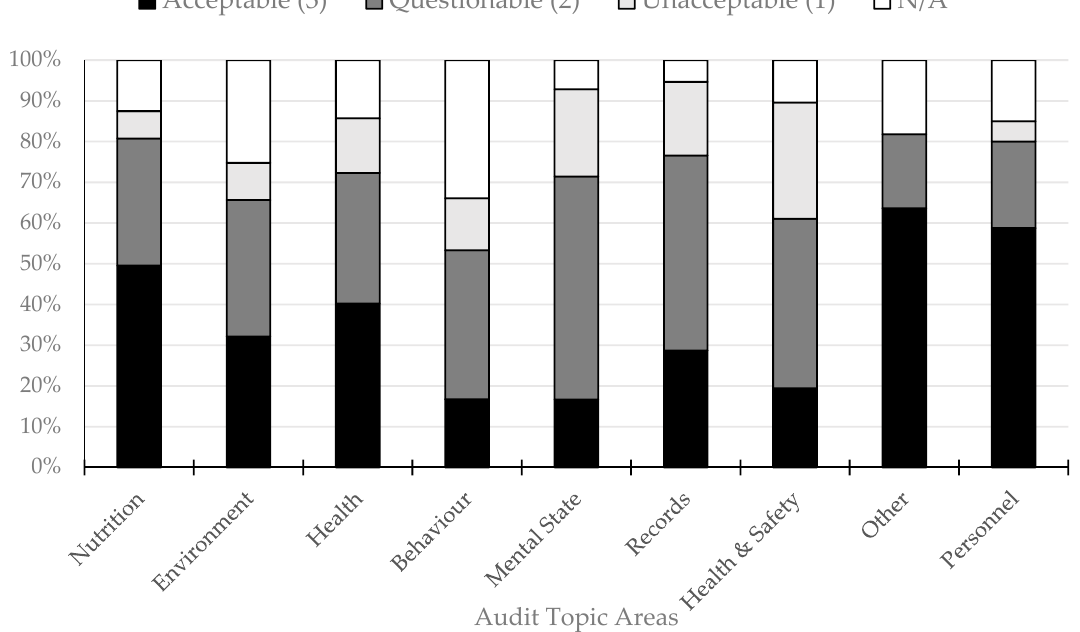
Figure 1. Overview of areas scored as having acceptable (scored 3), questionable (scored 2), unacceptable (scored 1) and N/A (not assessed or not available to assess) practices across all zoos assessed in the Wild Welfare Audit.